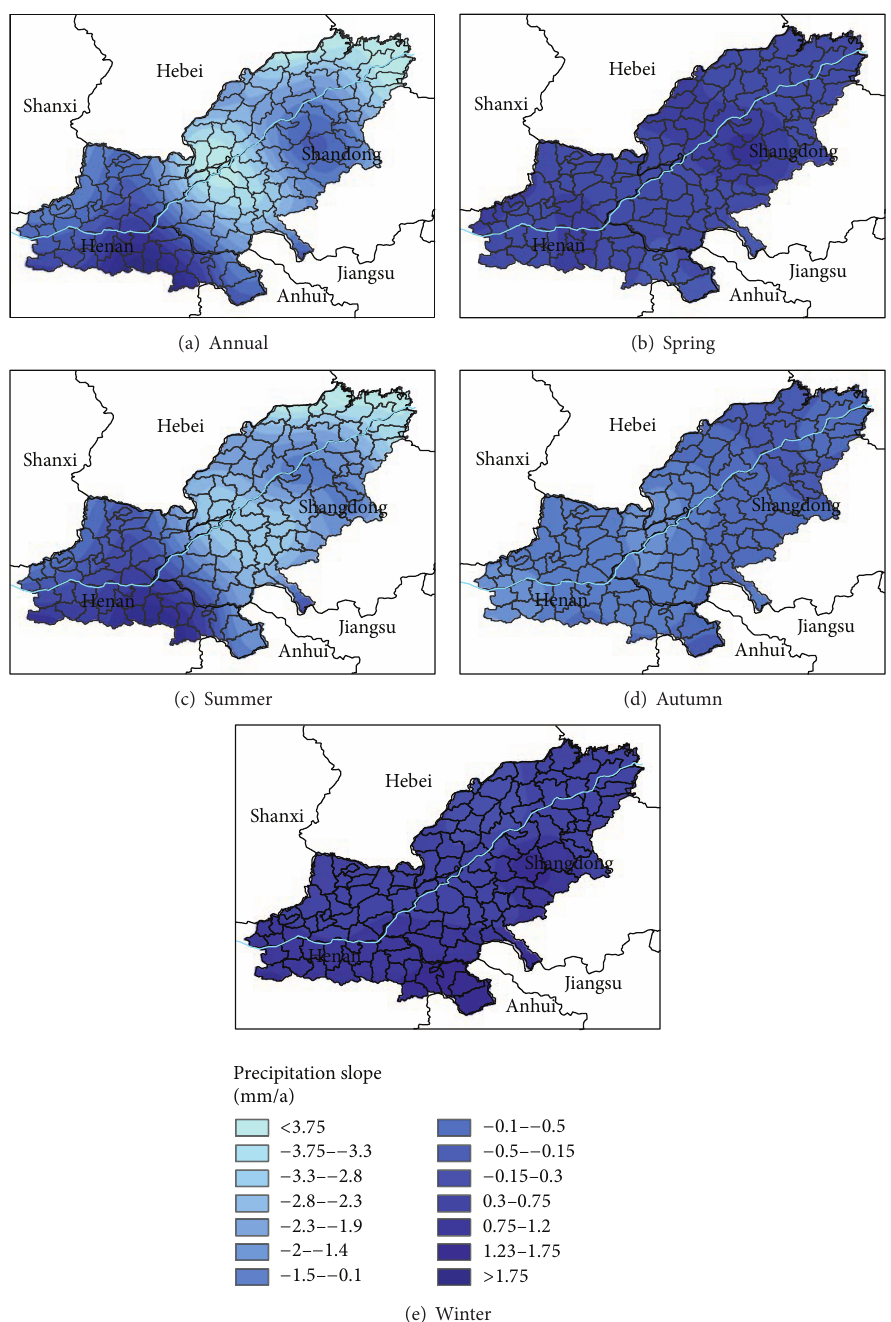
Figure 11: Spatial distribution of precipitation trend rates in the Lower Yellow River Region from 1960 to 2001.